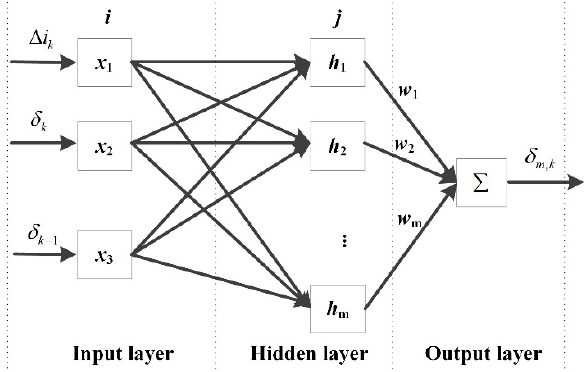
Figure 6. The structure of RBFNN.